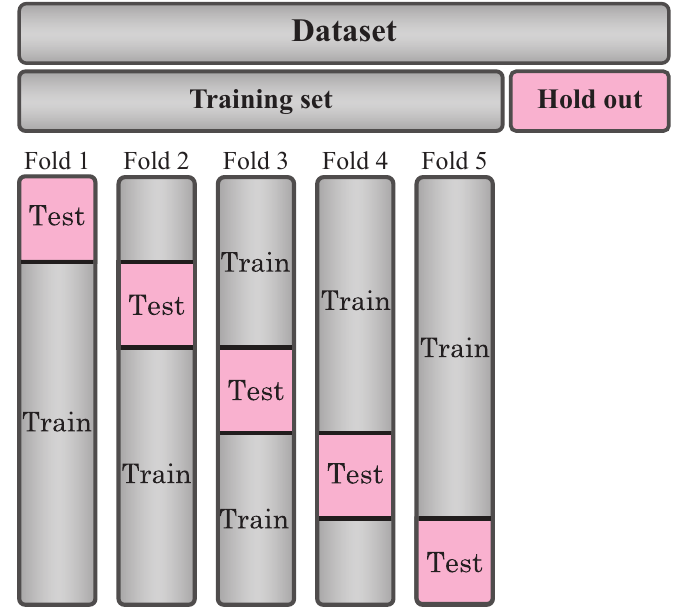
Figure 4. Schematic overview of the 5-fold cross-validation and hold out set.